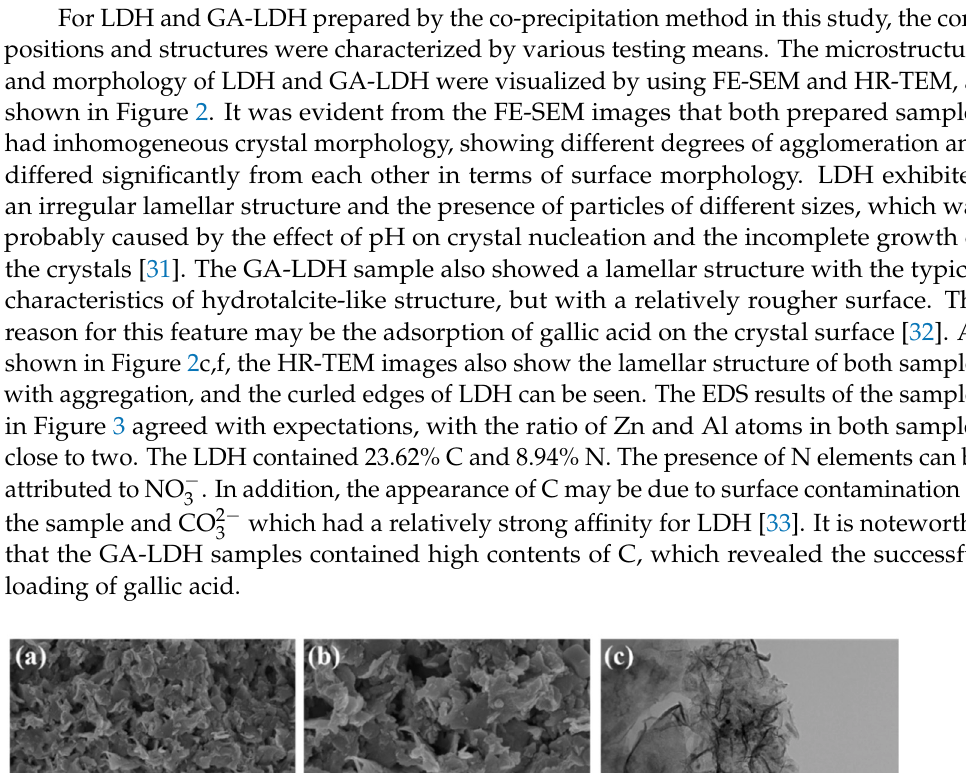
Figure 3. EDS results of ( a ) LDH and ( b ) GA − LDH. Figure 4 shows the XRD patterns of LDH and GA-LDH. The LDH presented intense and symmetric diffraction peaks at 10.03°, 19.93°, 33.80° and 60.34°, corresponding to the reflections of (003), (006), (009) and (110), respectively. The layer spacing in the (003) plane was calculated to be 0.88 nm by using the Bragg equation, indicating the existence of ni- trate anions between the layers of LDH [34,35]. The typical characteristic diffraction peaks in LDH were also observed in the GA-LDH curve. The 2 θ value of the (003) diffraction peak was 7.01°, so the layer spacing was 1.26 nm. Compared with LDH, the (003) diffrac- tion peak of GA-LDH shifted to a lower diffraction angle and the layer spacing increased, which implies that GA successfully intercalated into the layers of LDH. Figure 4. XRD patterns of LDH and GA − LDH.